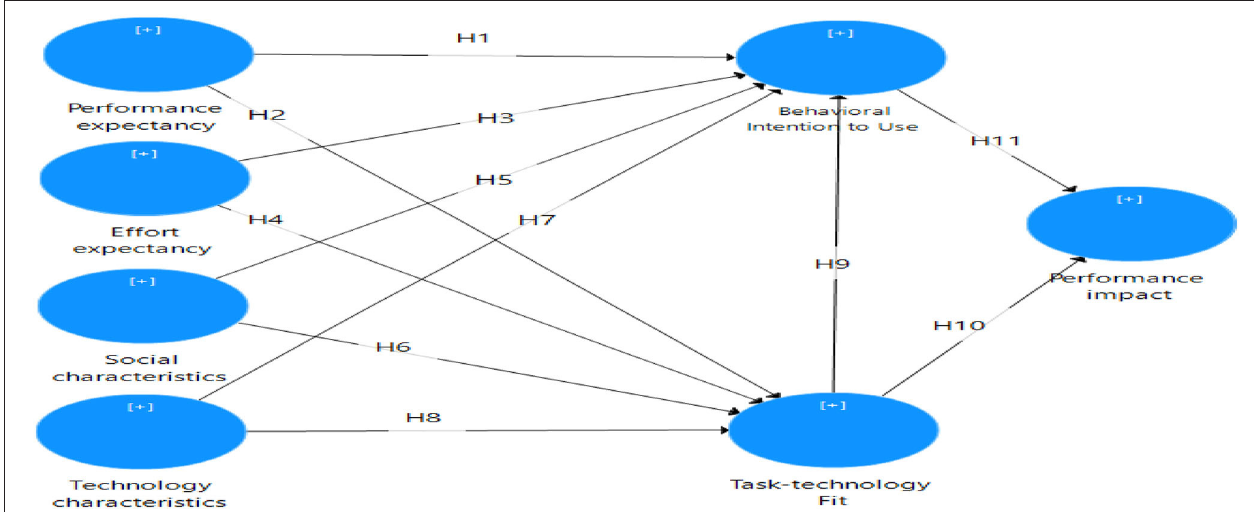
FIGURE 1 | Research model and hypotheses (source: